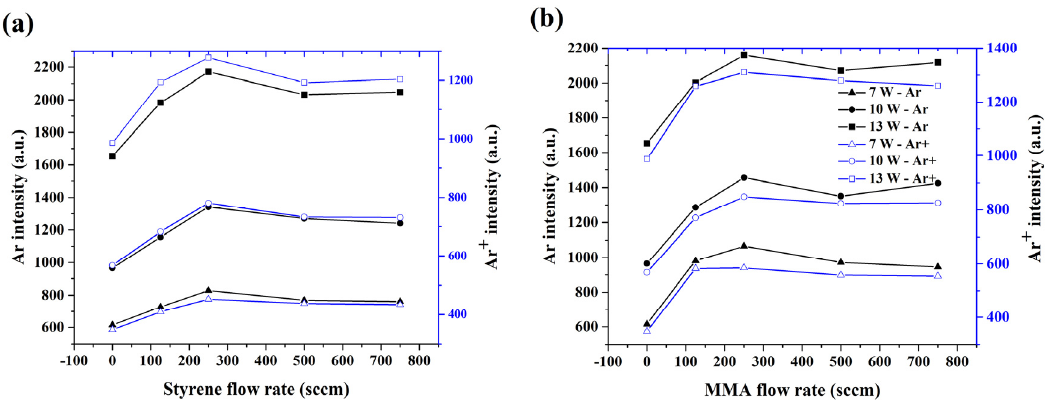
Figure 3. Dependence of the C line emission intensity on the carrier gas flow rate at different powers for the ( a ) styrene and ( b ) methyl methacrylate (MMA) monomers.